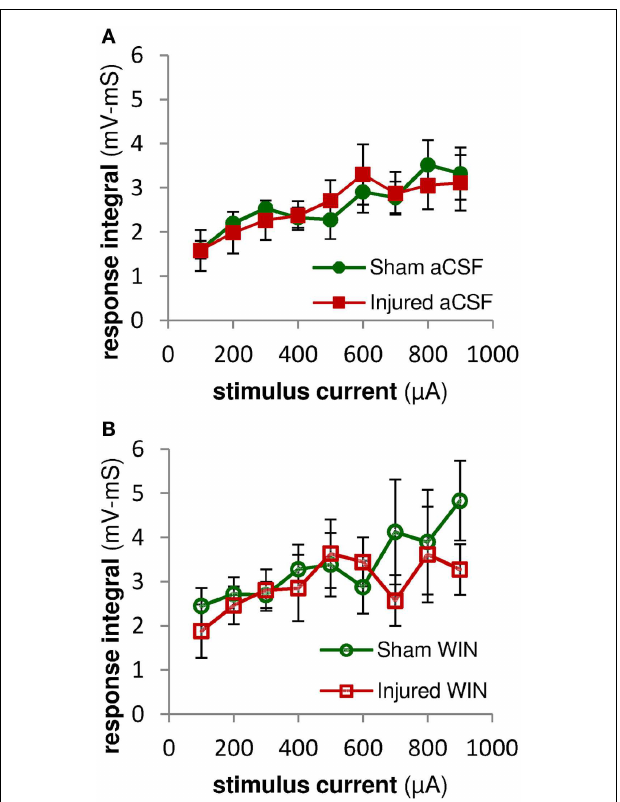
FIGURE 12 | Excitatory synaptic responses in pyramidal neuron recordings were not altered by injury or treatment with the cannabinoid agonistWIN55,2122 . Integral of SR-evoked responses in whole-cell current clamp recordings from CA1 pyramidal neurons over the first 2ms after the response onset. Since action potentials began as early as 2ms after the onset of the stimulus-evoked responses, we assessed the excitatory synaptic component of the evoked response by integrating the response over the first 2ms after the response onset. During this early time period, stimulus-evoked synaptic inhibition would not yet be active, and so the integral is a measure of excitatory synaptic activity (action potentials can be distinguished from synaptic potentials by the rate of rise of the response – see Sections “Materials and Methods” and “Analysis”). (A) No significant differences were observed between the excitatory responses in pyramidal neurons from sham versus injured mice, suggesting that injury did not alter the excitatory component of the evoked synaptic responses. (B) Integral over first 2ms of stimulus-evoked pyramidal neuron response as in (A) above.Treatment withWIN55,212-2 (100nM) did not significantly affect excitatory synaptic responses in either sham or injured animals, nor the difference between sham and injured. Mann-Whitney paired comparisons for 100–900 µ A stimuli (minimum, maximum, and median P values): sham aCSF versus shamWIN, 0.151, 0.999, 0.421; injured aCSF versus injuredWIN, 0.394, 0.999, 0.931; sham aCSF versus injured aCSF